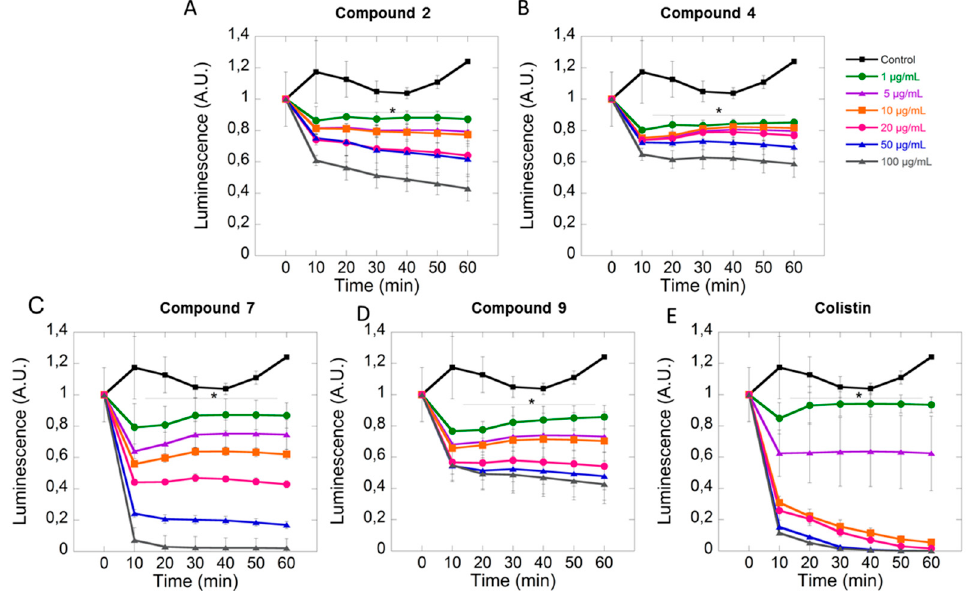
Figure 3. Phenylselenium-substituted steroids decrease the metabolic activity of MDR Pseudomonas aeruginosa strain. Panels A – D show activity of tested agents against planktonic form of P. aeruginosa Xen 5 in comparison to colistin ( E ). Statistical significance for the samples treated by tested compounds compared to control was marked by (*), p ≤ 0.05. Results from 3 measurements ±SD.